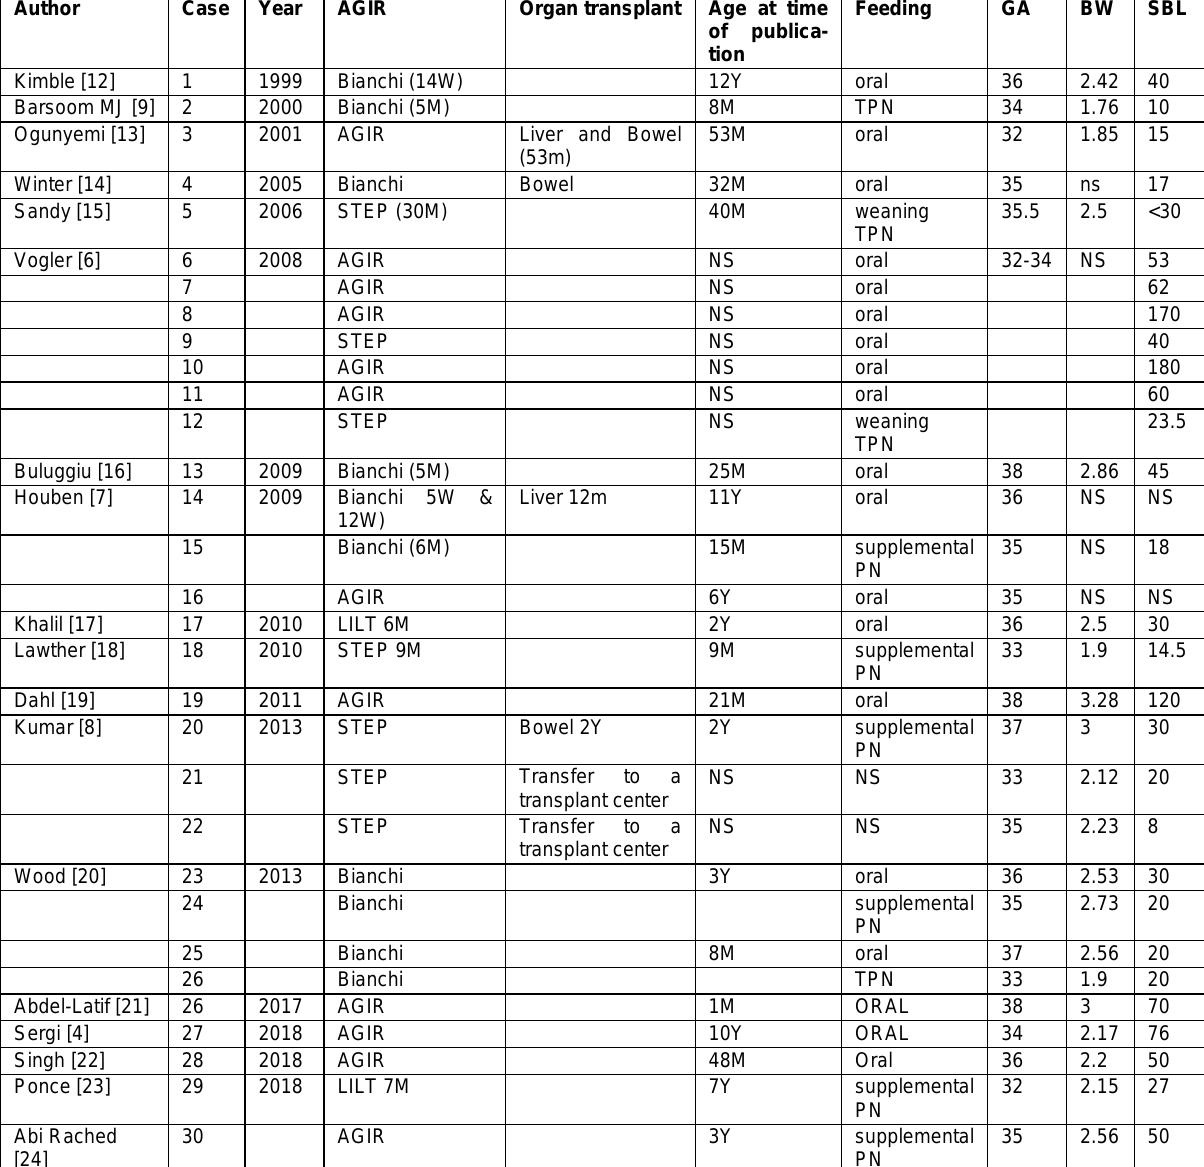
Table 1: Survivors of vanishing gastroschisis